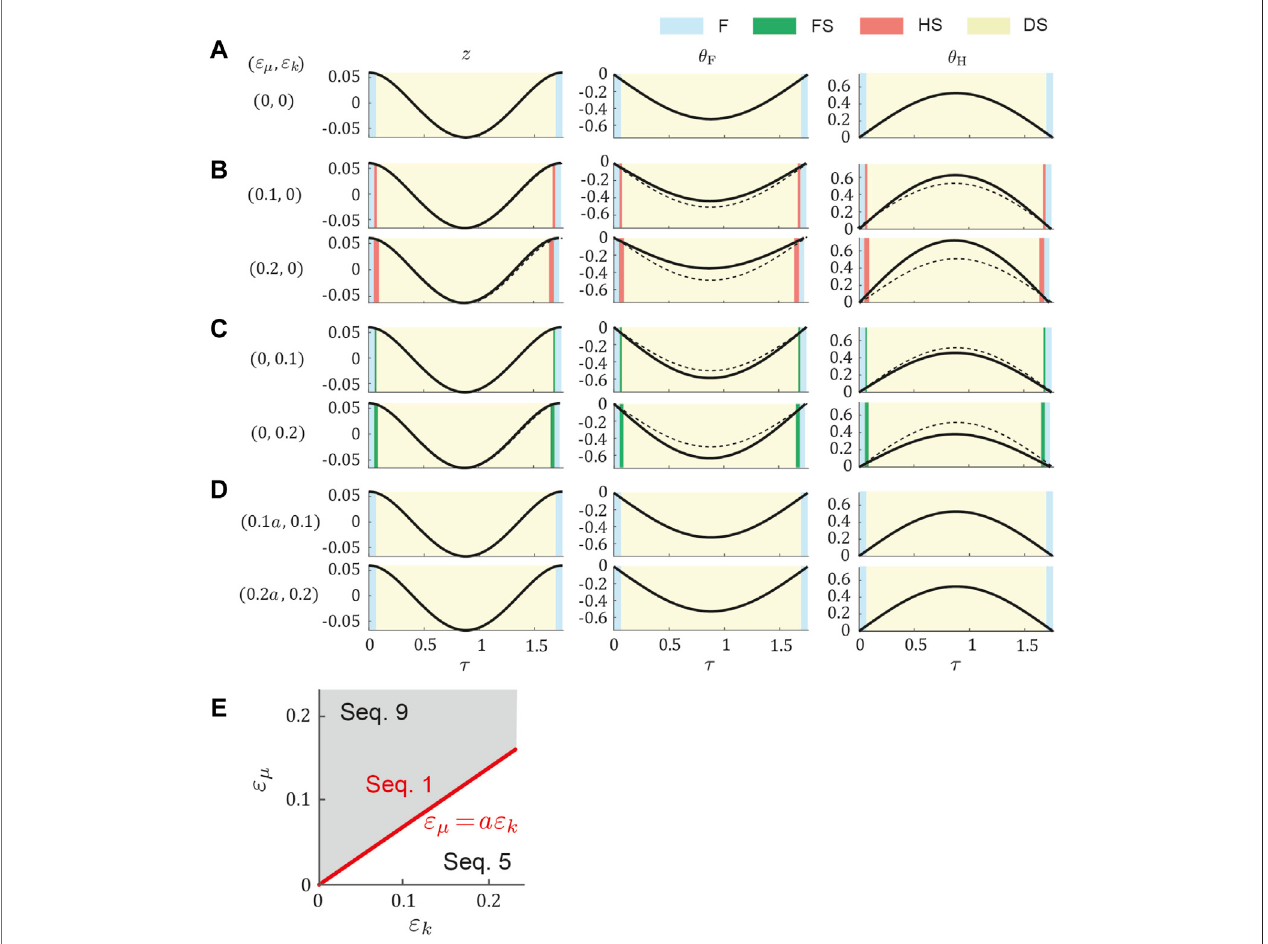
FIGURE 3 | Gait dependence on ε k and ε μ in dog model. Time pro fi le of periodic solution (A) for the symmetric model ( ε k = ε μ = 0) and those for two values of (B) ε μ with ε k = 0, (C) ε k with ε μ = 0, and (D) ε k with ε μ = a ε k . Cyan, green, pink, and yellow regions indicate fl ight (F), fore stance (FS), hind stance (HS), and double stance (DS), respectively. Dotted lines indicate the periodic solution of the symmetric model. (E) Gait dependence on ε k and ε μ .